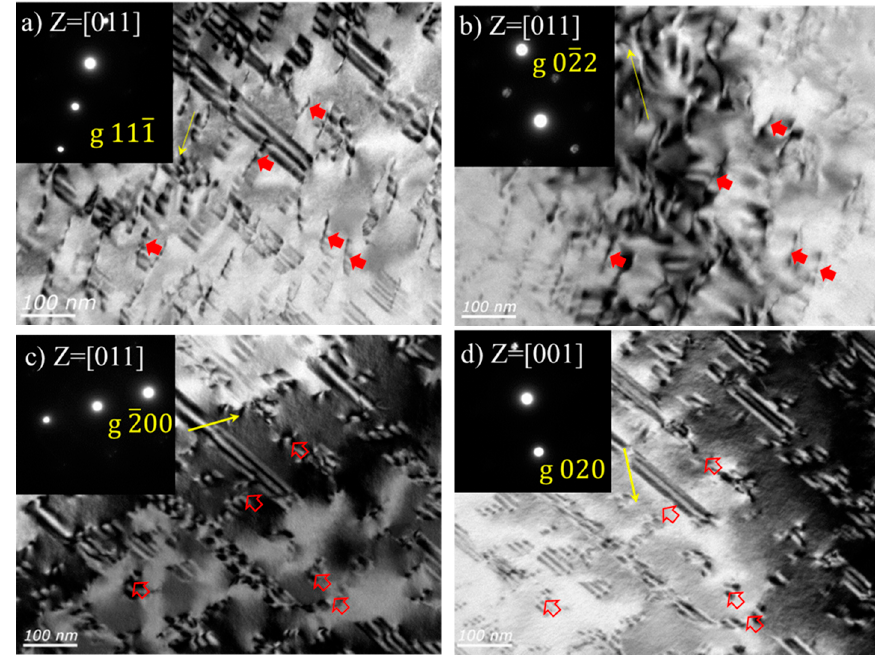
Figure 9. A series of TEM BF images of the 10% tensile deformed LDX-2101 specimen under di ff erent two-beam di ff racting conditions: ( a ) z = [ 011 ] , g = 111, ( b ) z = [ 011 ] , g = 022, ( c ) z = [ 011 ] , g = 200, ( d ) z = [ 001 ] , g =